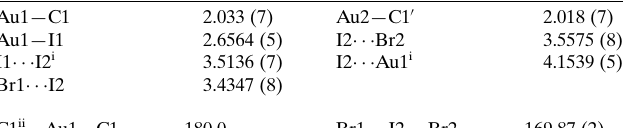
Table 2 Selected geometric parameters (A˚ , (cid:3) ) for 4 .